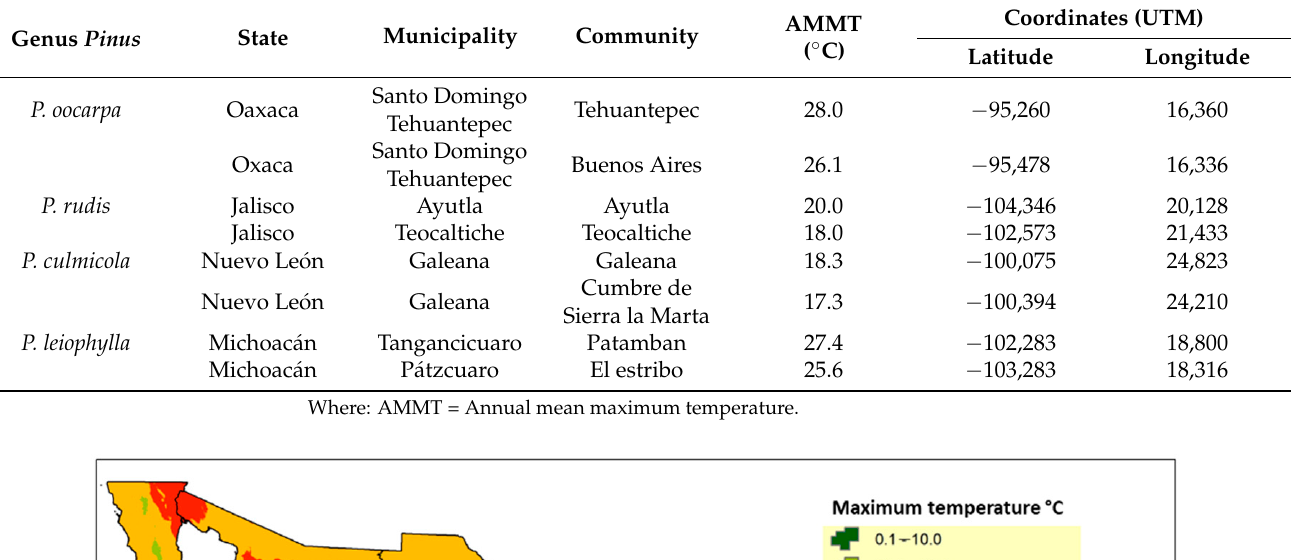
18,316 Where: AMMT = Annual mean maximum temperature. 3.2. Calculation of the Economic Value of Seed Storage for the 2018 to 2050 Period Total Collection Costs per Accession (TCCA) In the FESI-SB, the unit cost of collection, preparation, and storage of the seed acces- sions follow the guidelines expressed in the Kameswara et al. [33] manual. In the FESI-SB there are two collection cost values (one for the northern and southern regions and an- other one for the central zone). Thus, the different geographic distribution areas of the seeds of the species collected in the country FESI-SB staff are summarized in Table 4. To obtain precise estimations of the total costs (fixed costs plus variable costs), we followed the recommendations of Ávila [34] and Brambila [35], who suggest that TC is equal to twice the VC. Table 5 shows a summary of the TC for seed collection from populations of the four species with the AMMT.